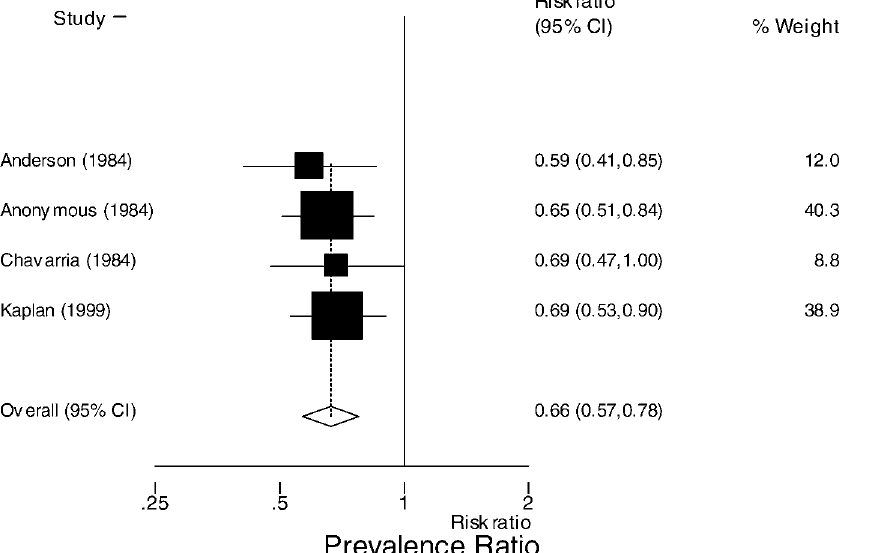
Figure 2. Meta-Analysis of Prevalence of Diarrhea at 24 h among Those on Loperamide Compared with Controls The x -axis uses the log scale. Random-effects prevalence ratio 0.66 (95% CI: 0.57 to 0.77). Test for heterogeneity, p ¼ 0.914.